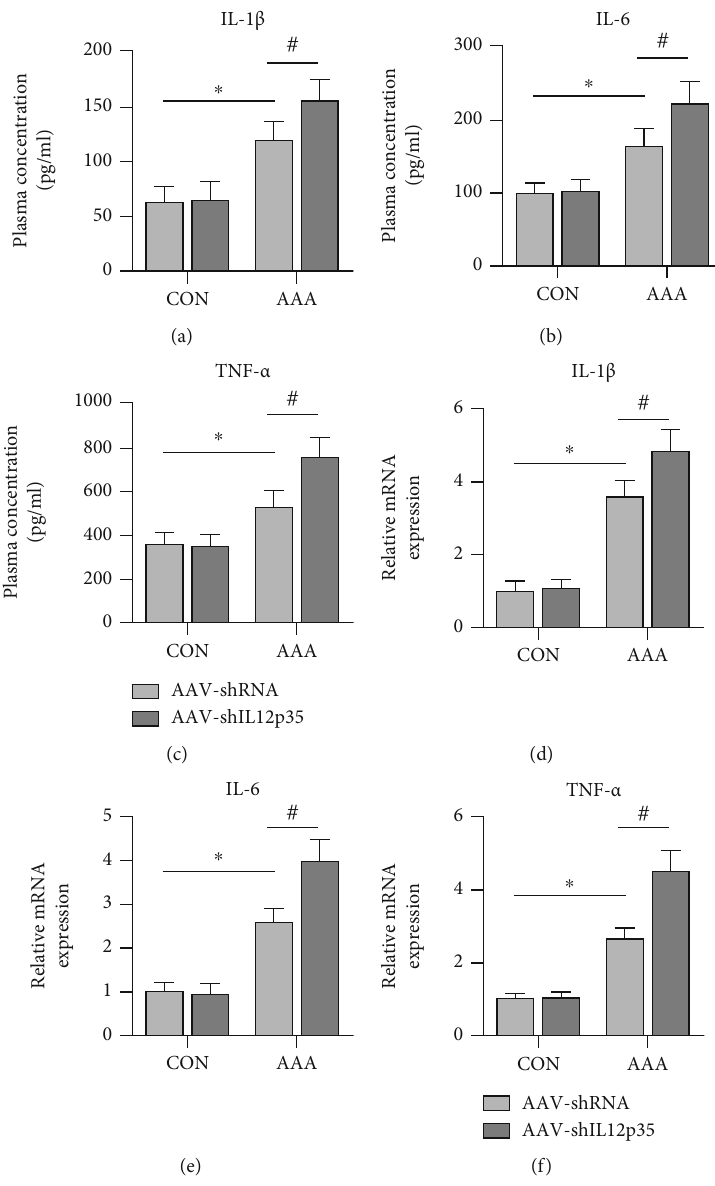
Figure 3: IL12p35 silencing exacerbates the in fl ammatory response after Ang II infusion. (a – c) ELISA analysis of serum IL-1 β , IL-6, and TNF- α levels of mice in the four groups ( n = 8 per group). (d – f) PCR analysis of IL-1 β , IL-6, and TNF- α mRNA expression in murine aortic samples ( n = 8 per group). ∗ P < 0 : 05 compared with the control group; # P < 0 : 05 compared with the AAA